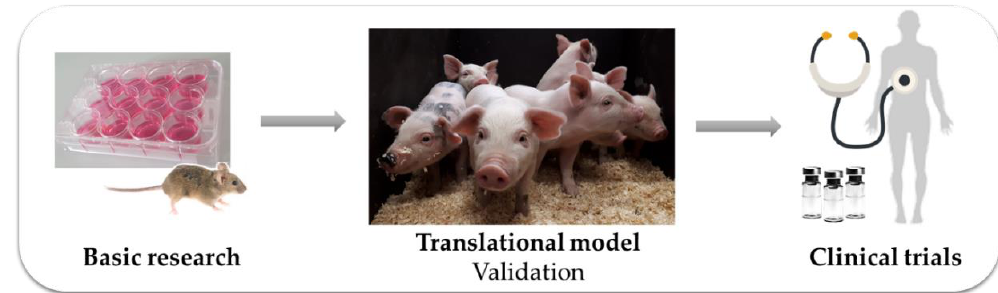
Figure 1. The pig as a biomedical model. Pigs can help translate basic research findings into new medical drugs and procedures; ‘bridging the gap between bench and bedside’.